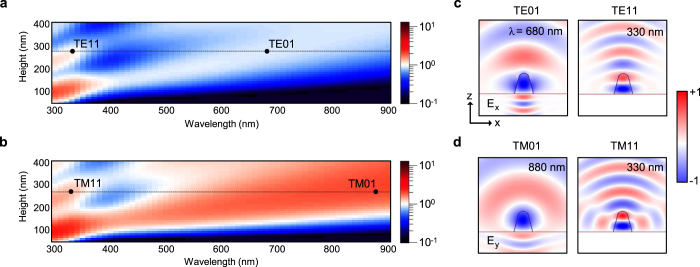
Calculated resonant modes of the EBID dielectric nano-rod antenna.(a,b) 2D maps of the total scattering efficiency on a log scale as a function of the wavelength and the height of the nano-rod antenna for TE- (a) and TM-polarized (b) illumination. (c) Ex-field profiles of the TE01 (λ = 680 nm) and TE11 modes (λ = 330 nm) for the nano-rod with a height and width of 280 and 178 nm, respectively. (d) Ey-field profiles of the TM01 (λ = 880 nm) and TM11 modes (λ = 330 nm) of the nano-rod shown in (c). The field components in the profiles are those of the scattered field, not the total field.